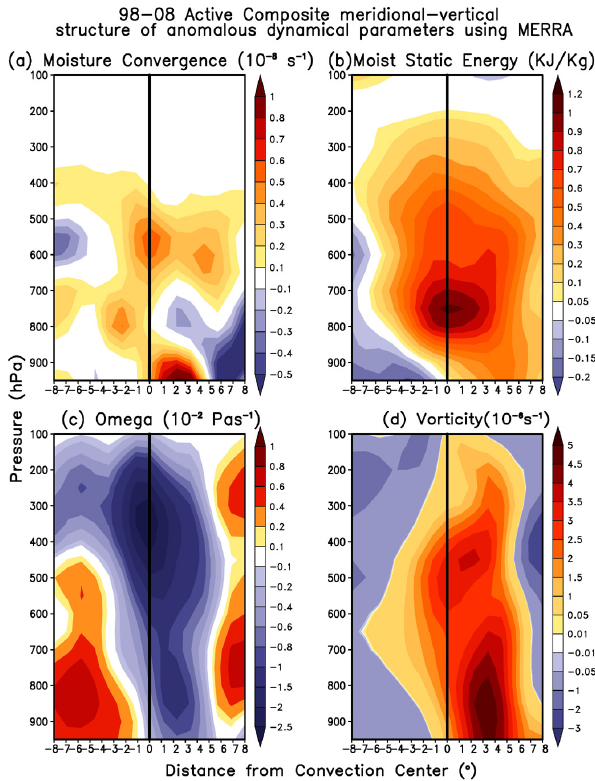
Fig. 10. H¨ovm¨oller (Latitude-time) diagram of rainfall (mmday − 1 ) (shaded) superimposed with the cloud ice (con- tour) (mgm − 3 day − 1